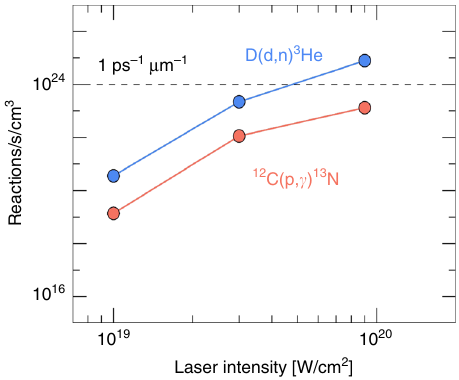
Fig. 5 Sensitivity of nuclear reaction rate to changes in laser